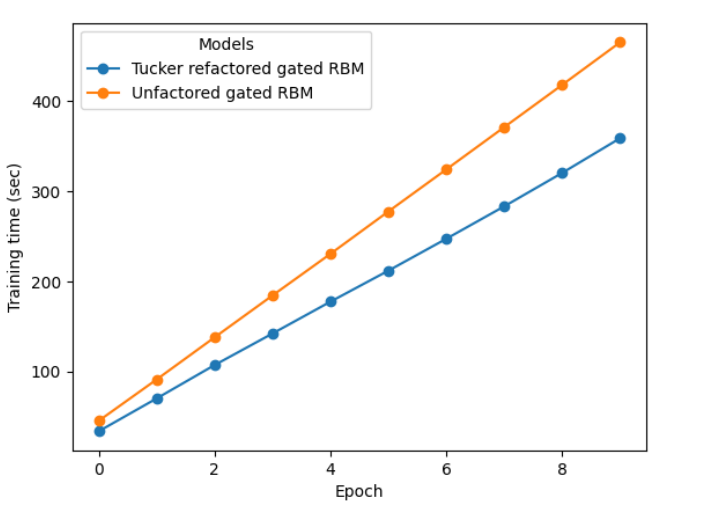
Figure 16. Training time in Tucker refactored vs unfactored gated